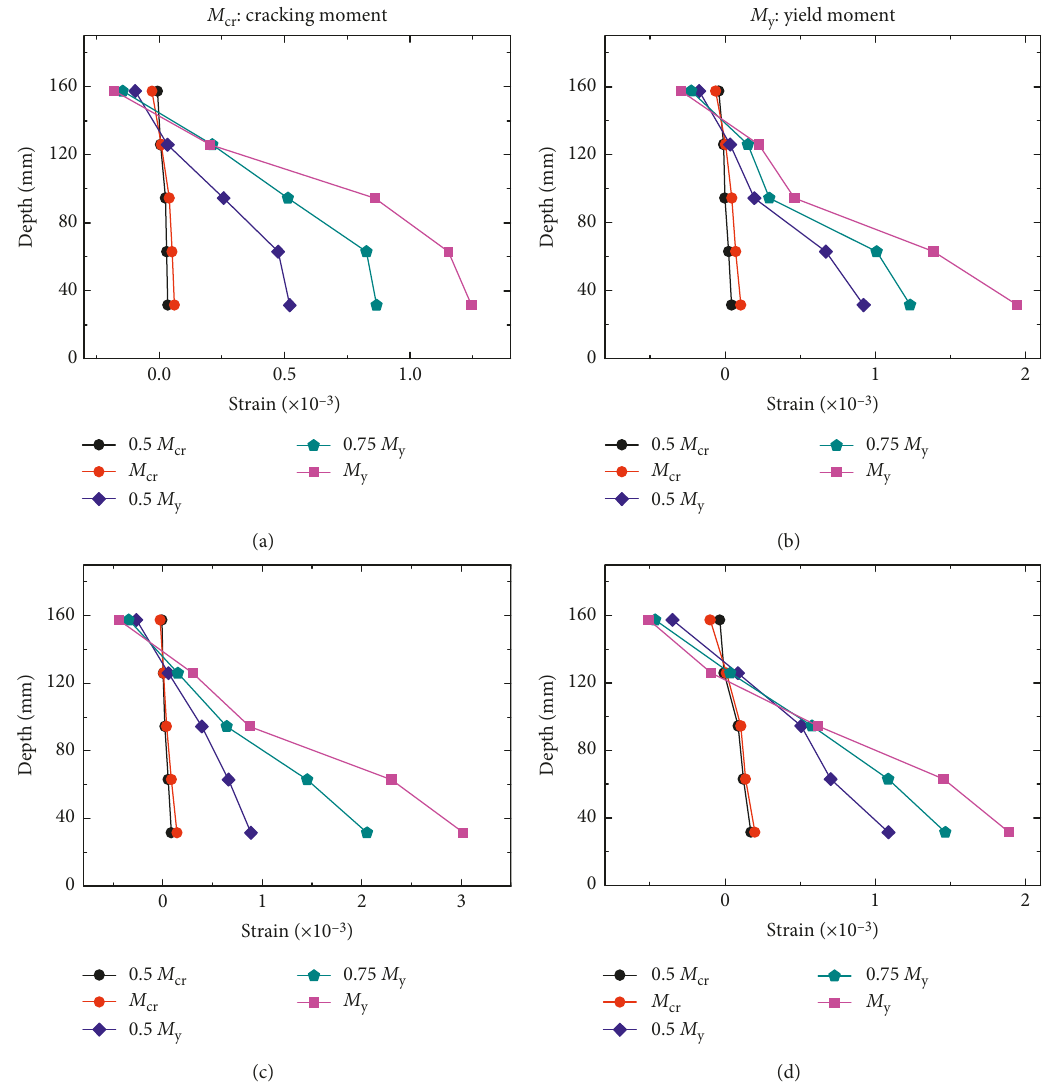
Figure 10: Variation in the strain along the depth: (a) Slab S1 (b) Slab S2, (c) Slab S3 and (d) Slab